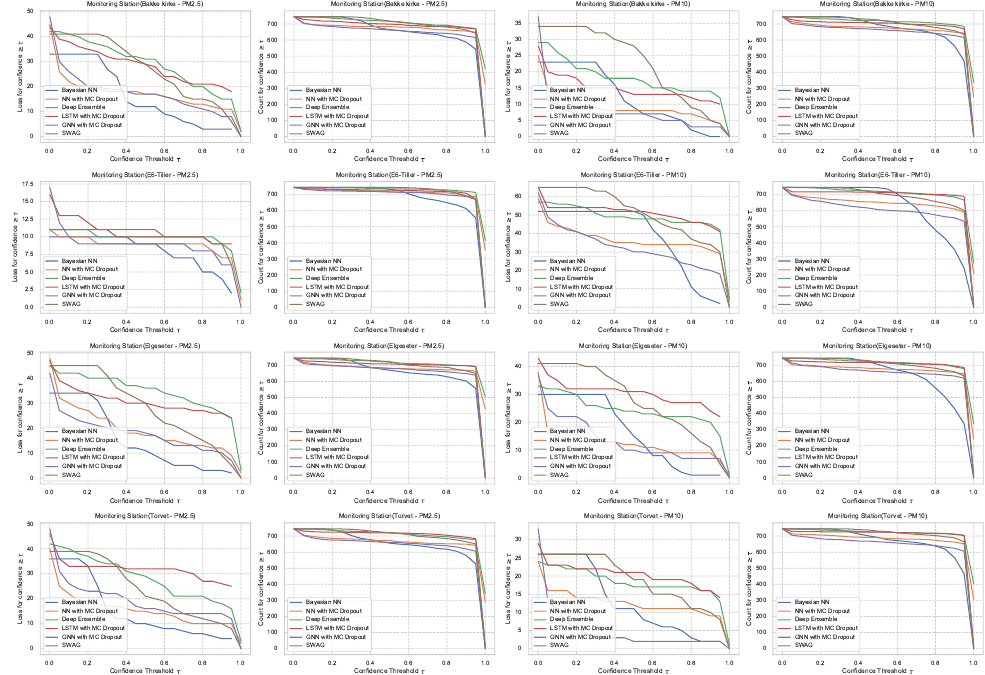
Figure A6. Comparison of confidence reliability for the selected probabilistic models in the threshold exceedance classification task in all monitoring